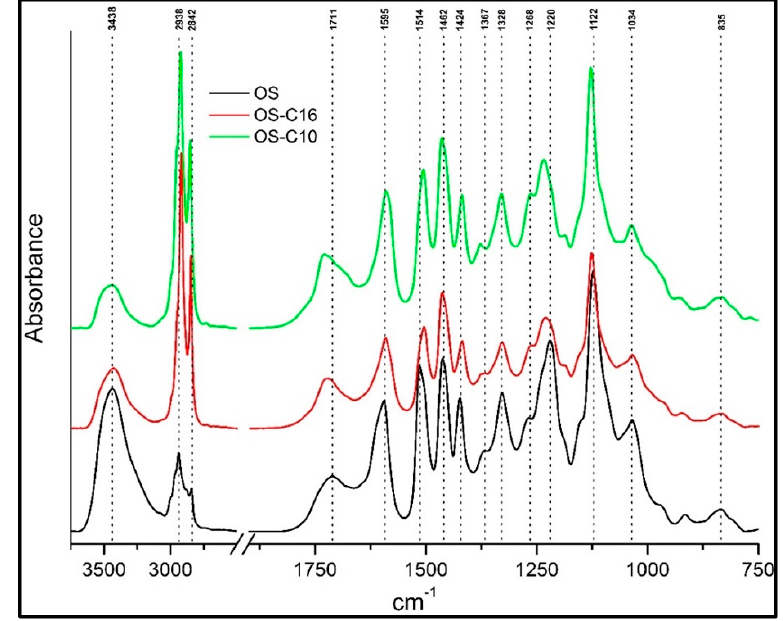
Figure 1. FT-IR spectra of nonfunctionalized organosolv (OS) lignin etherified with C10 (OS-C10) and C16 (OS-C16) alkyl chains. Processes 2020 , 8 , x; doi: FOR PEER REVIEW